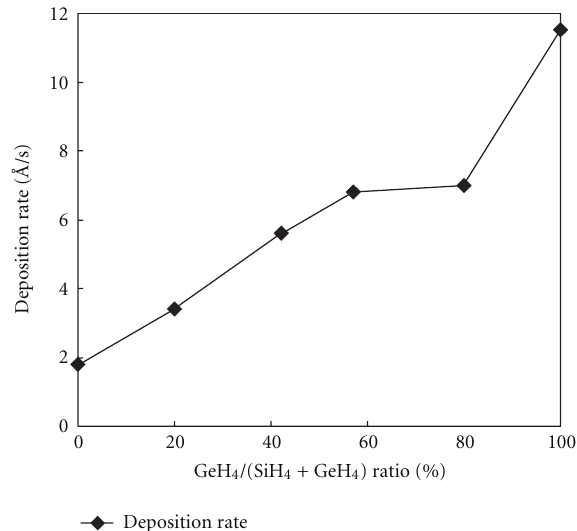
Figure 1: Variation of deposition rate as a function of the gas ratio.